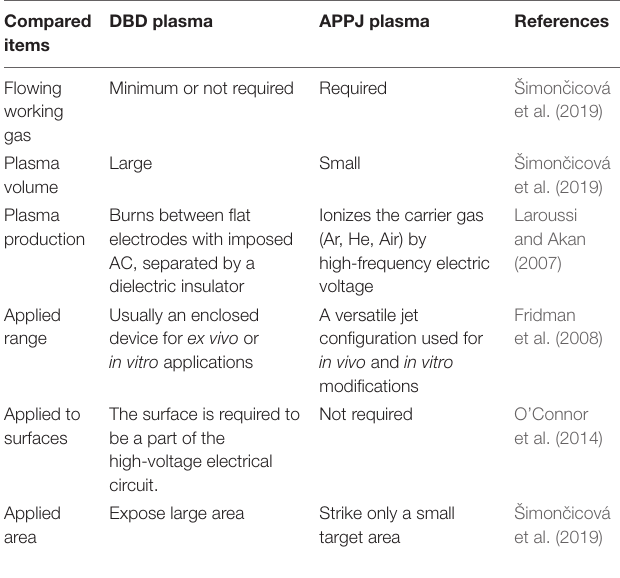
TABLE 1 | Summary of comparable characteristics of DBD and APPJ